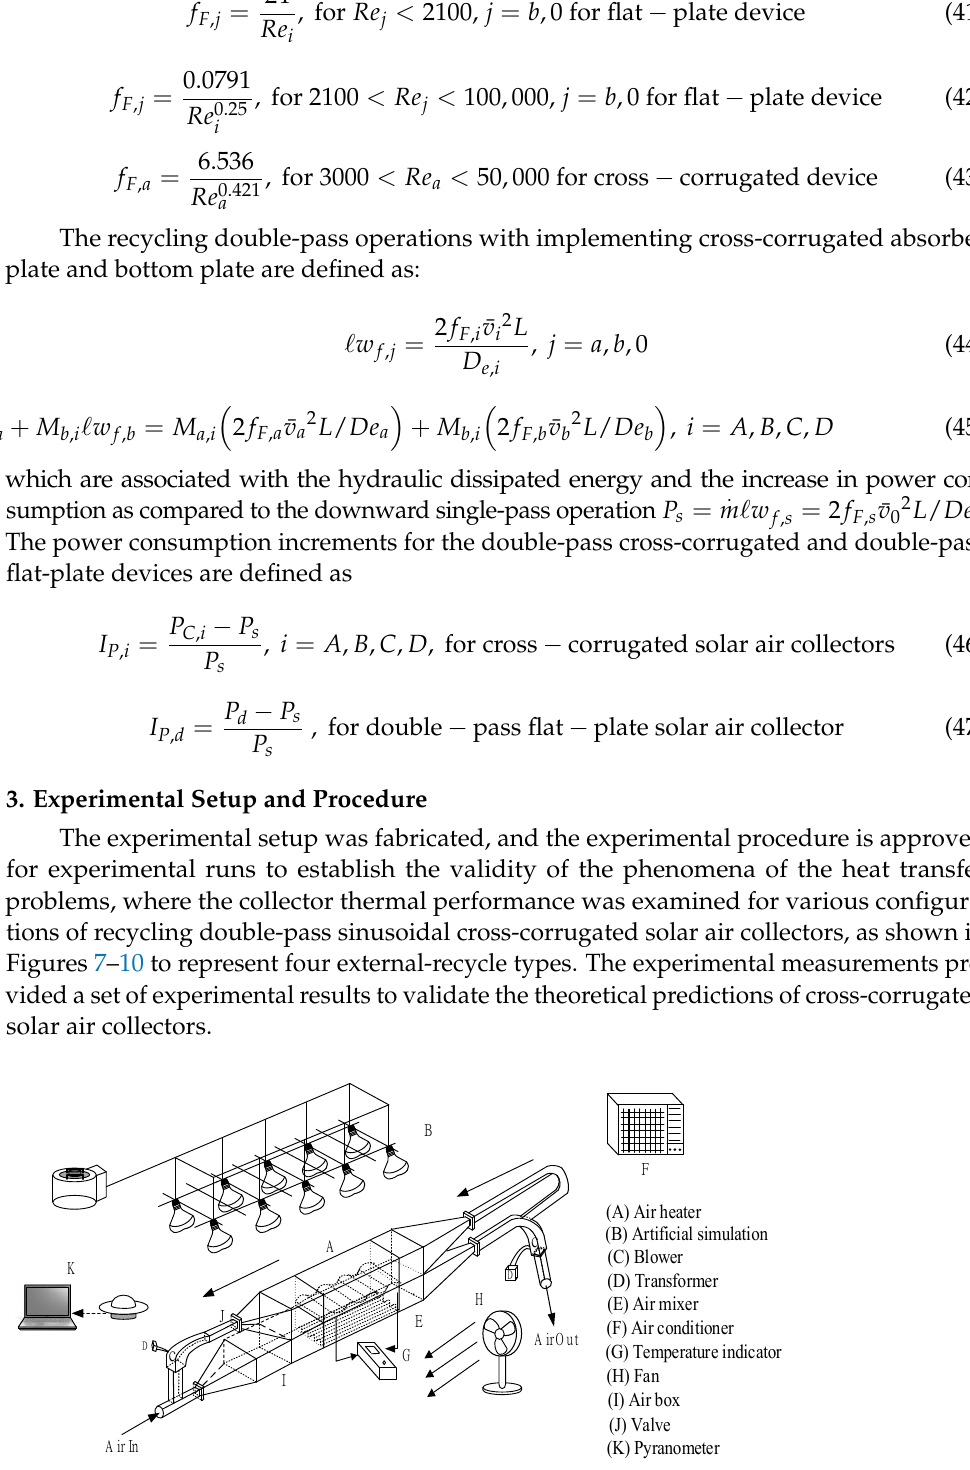
Figure 7. Experimental setup of a recycling cross-corrugated solar air collector ( Type A ).